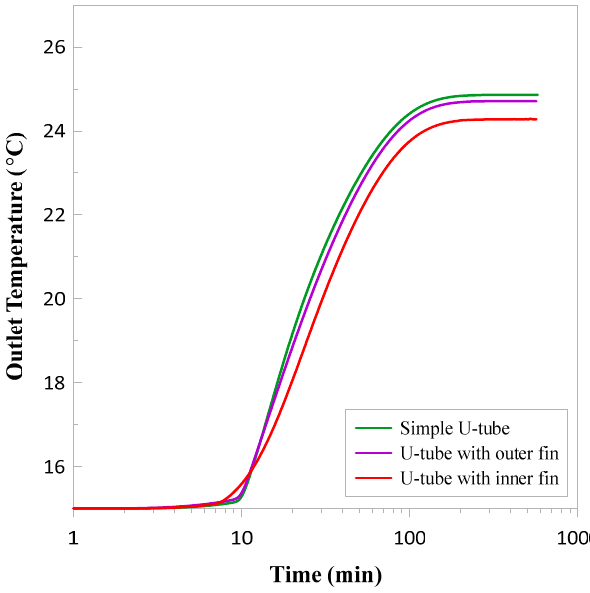
Figure 5. Outlet temperature of fluid in simple and finned U-tube GHE.